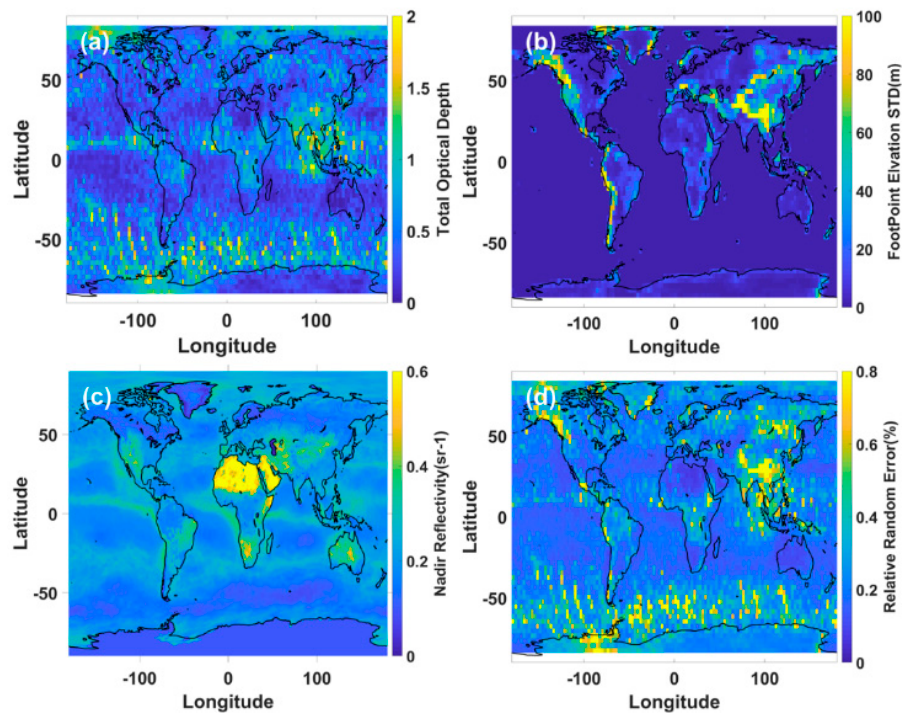
Figure 5. ( a ) the monthly mean TOD of clouds and aerosols from CALIPSO at 532 nm in September 2016. ( b ) the surface roughness in lidar footprints; ( c ) the simulated global monthly mean nadir surface reflectivity; and ( d ) the global distribution of monthly mean RREs for AC-IPDA lidar in September 2016. Table 2. The September 2016 monthly mean RREs of AC ‐ IPDA lidar changes with latitudes.